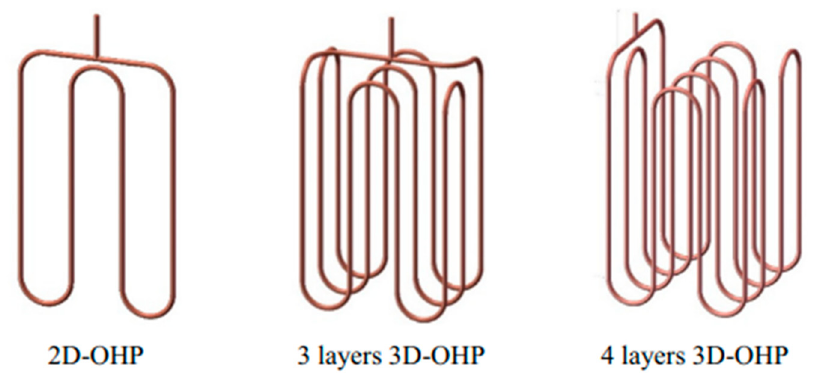
Figure 16. Multi-dimensional oscillatory heat pipe [100]. Reproduced from reference 100 with permission from Elsevier B.V., copyright 2019.